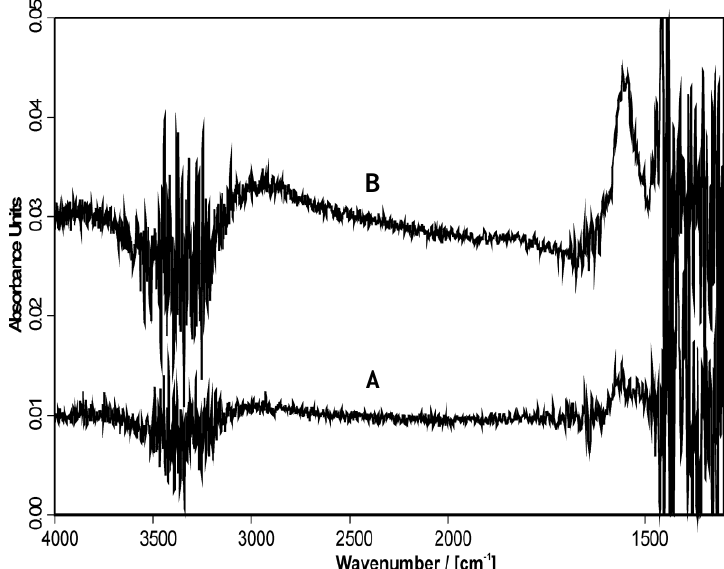
Figure 13. ATR-FTIR spectra of in-situ formed PEI/PAC complexes at n contact to cellulose film under the conditions: ( A ) 1. PEI 2. PAC (0.001 M); ( B ) 1. PAC 2. PEI (0.001 M) (see